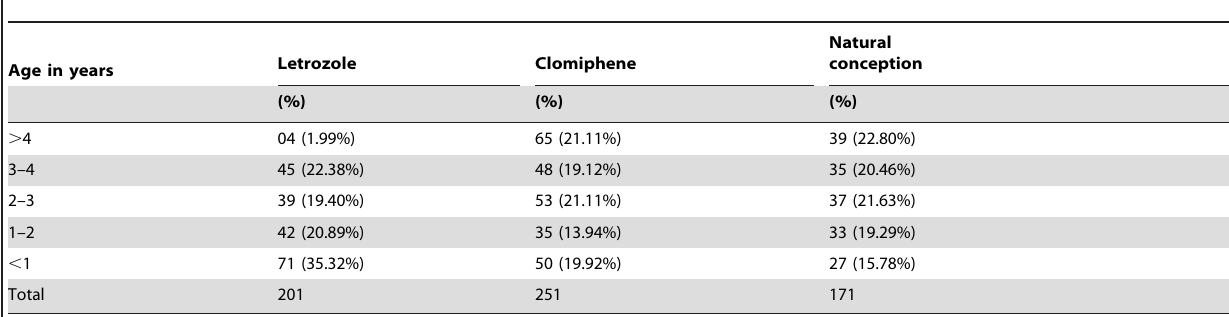
Table 1. Age–wise distribution of